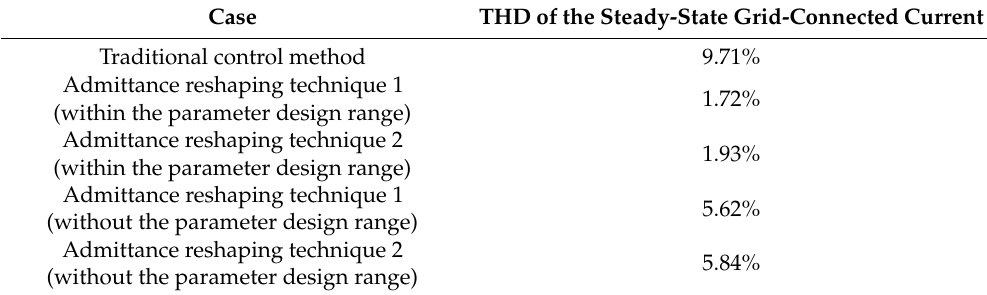
Table 2. The experimental results of the grid-connected current.